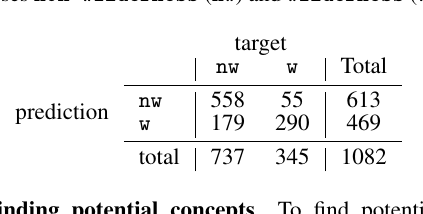
Table 1. Confusion matrix of the scene classification results of classes non-wilderness ( nw ) and wilderness ( w ).